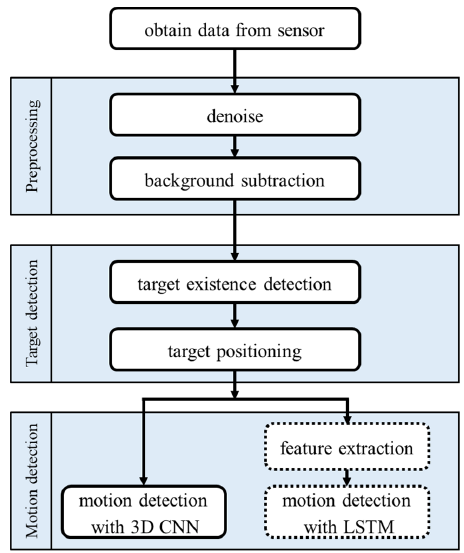
Figure 3. Flow chart of the proposed system.